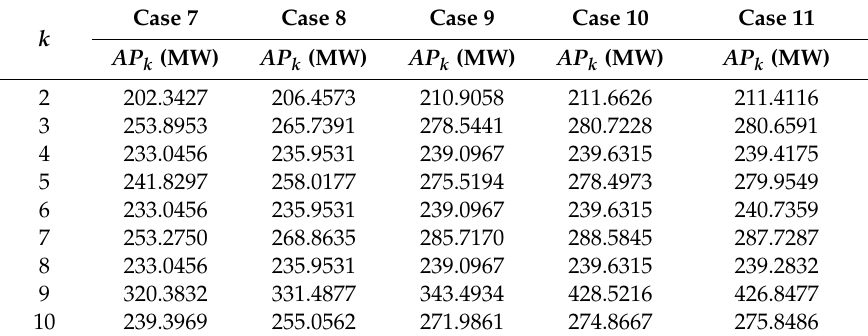
Table A3. The best solutions for system 3 found by MSFS.